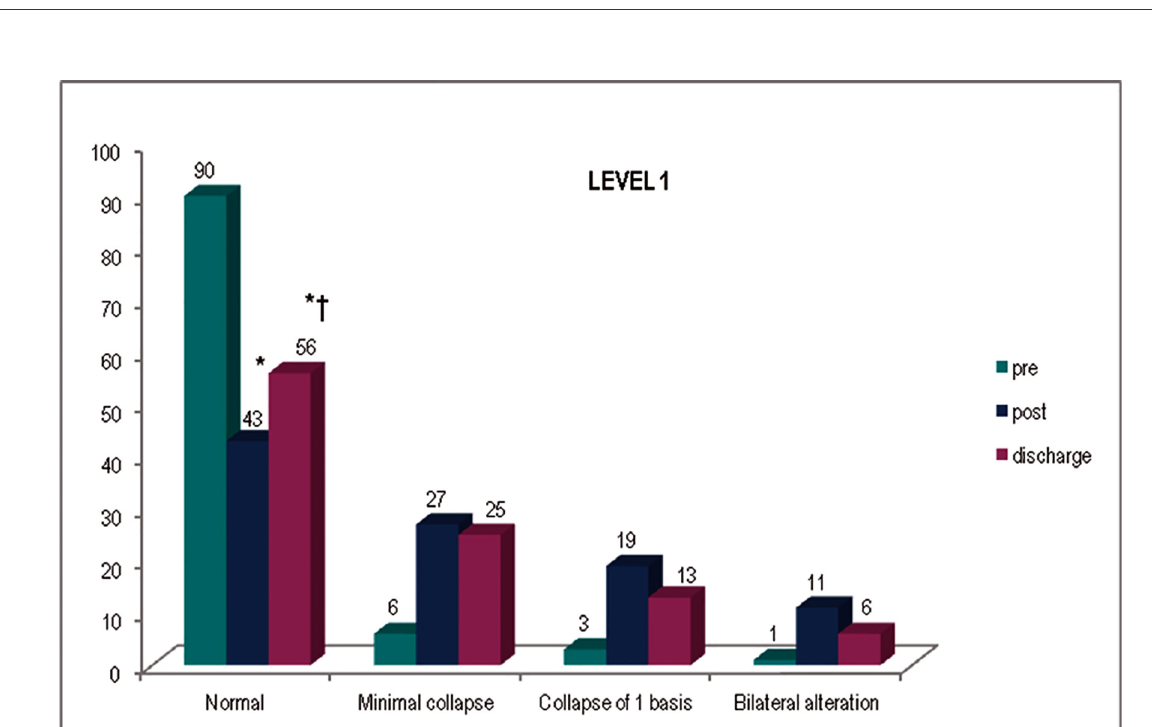
Fig. 2 - Percentage of radiological changes of level 1 in the pre, post and discharge of study.